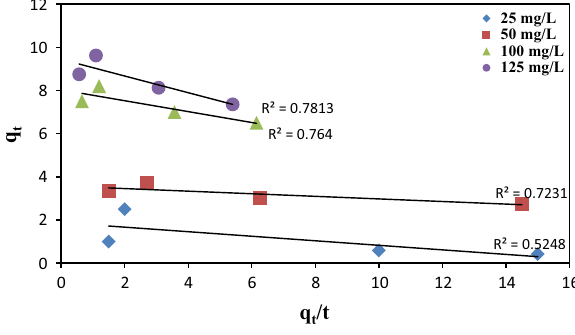
Fig. 7 Fitting of the Ho(III) linear model with the adsorption kinetic data